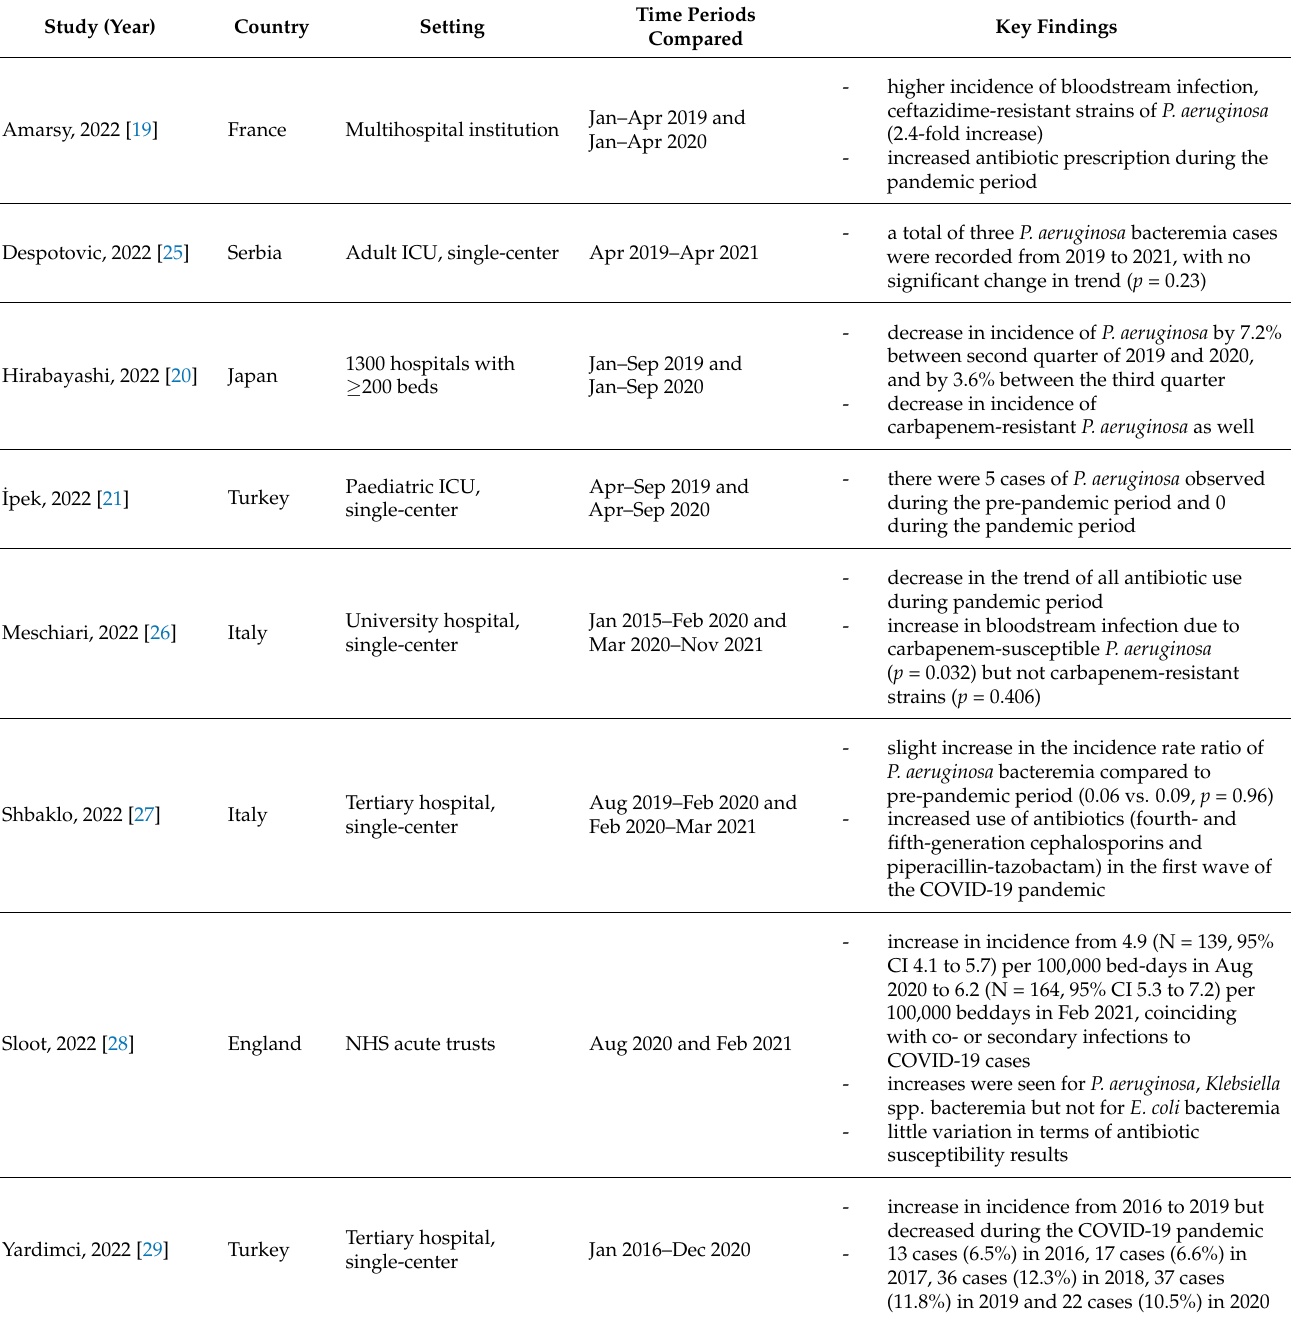
Table 2. Characteristics of the studies reviewed (arranged alphabetically by the first author’s last